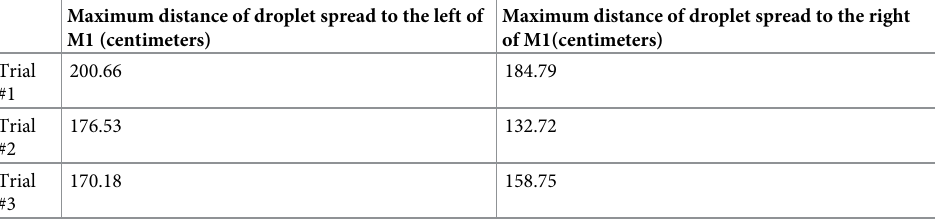
This table displays the measurements of the maximum droplet spread travelling laterally from M1.